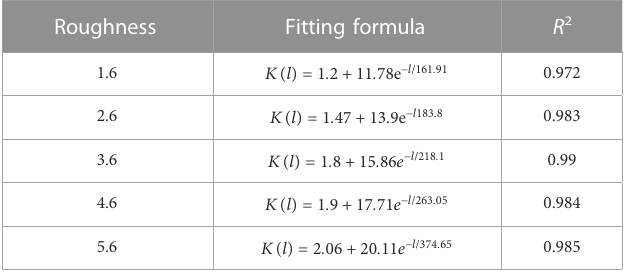
TABLE 5 Fitting Equations of bulk modulus and rock sizes. Roughness